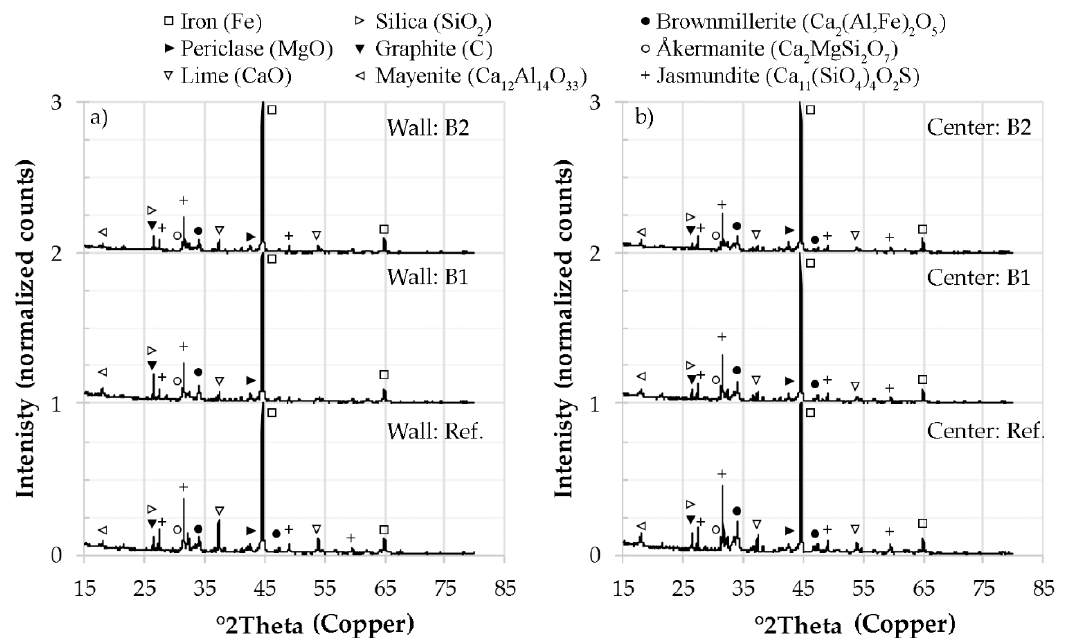
Figure 4. Diffractograms of the briquettes that have gone through the ( a ) wall program and ( b ) center program of the laboratory-scale BF experiments.